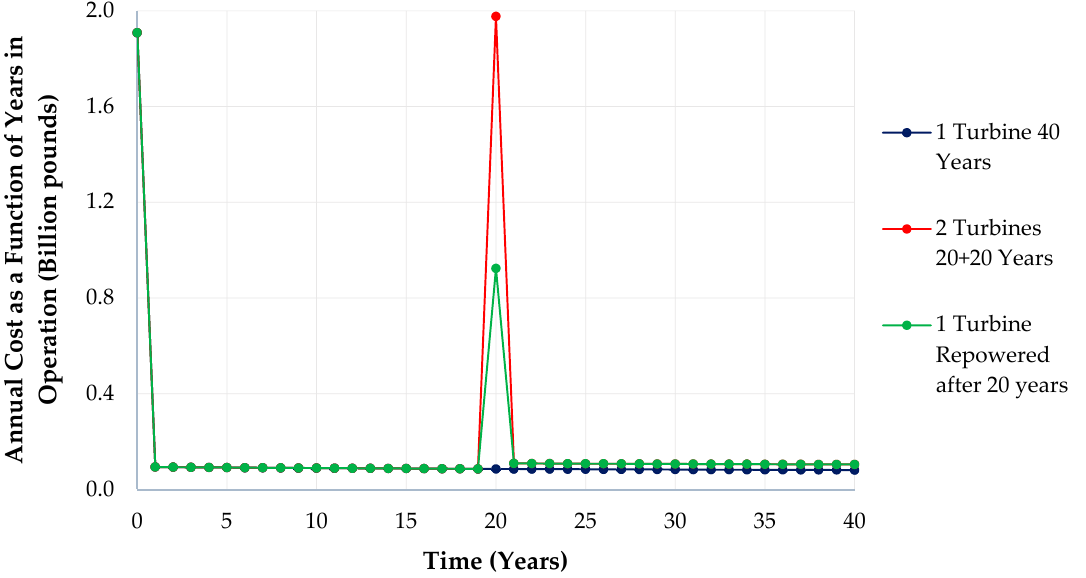
Figure 5. London array comparison between life extension, reinstalling and repowering.